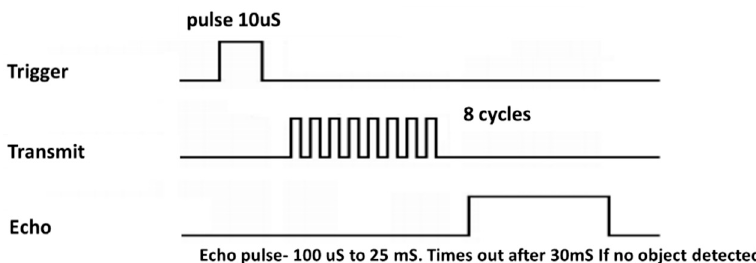
Figure 2. Working of ultrasonic sensor, ( a ) Plain road, ( b ) Speed bump, and ( c ) pothole.